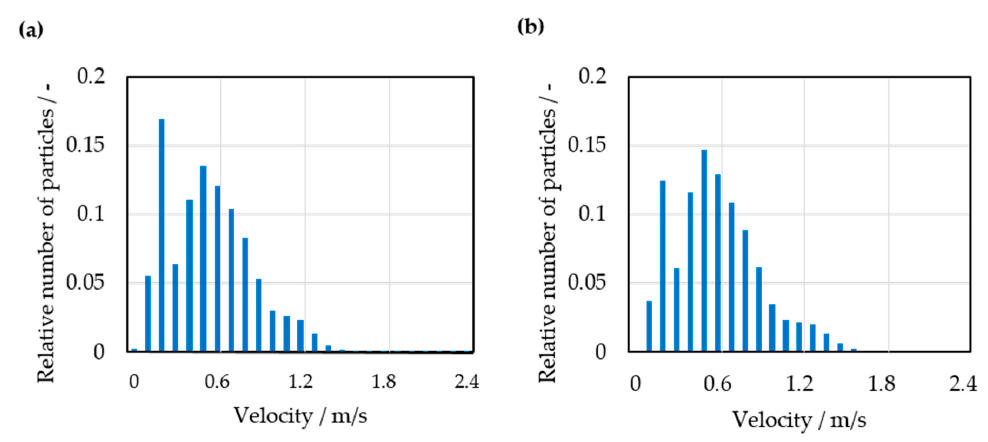
Table 5. Average values of the particle’s dynamics obtained in different simulation cases. Figure 8. Velocity distribution of the particles for the dry case I ( a ) and in the wet case II ( b ). In both cases, two peaks can be seen, one at a velocity of 0.2 m/s and the second at 0.6 m/s. In the dry simulation, over 30.1% of the particles have a velocity under 0.2 m/s, whereas in the wet case, it is only around 16.0% of the particles. The particles with a low velocity are the particles which have direct contact with the wall. These particles are slowed down by friction with the stationary wall. Most of the particles in the bed move at a velocity of 0.6 m/s. The highest velocity reaches the particles after contact with the rotor plate due to the high rotational speed of the plate. In the dry case, the highest peak is the first one, whereas in the wet case the second is the highest. Moreover, the distribution around the velocity of 0.6 m/s is more homogeneous in the wet case than in the dry case. While in the dry simulation there are no more particles with a velocity faster than 1.2 m/s, over 4.4%